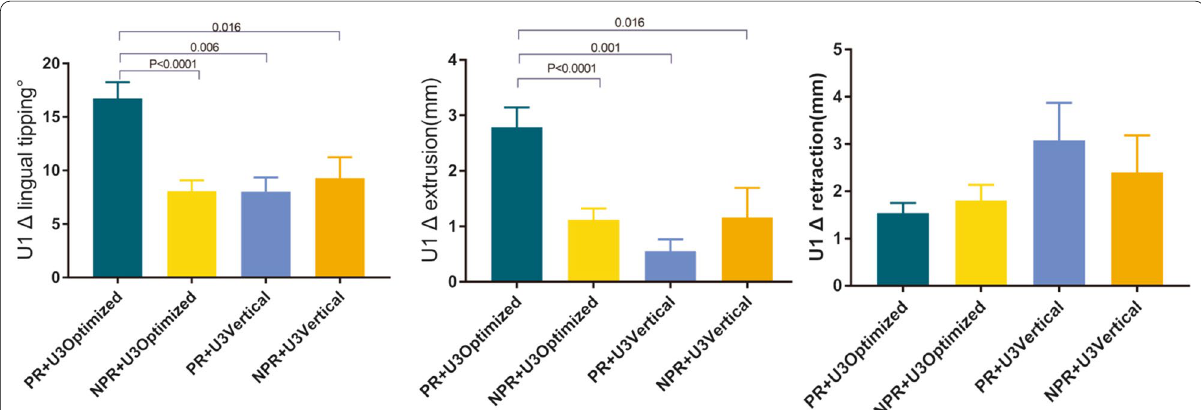
Fig. 3 Variation of upper incisor movements using different canine and incisor attachments. PR, power ridge used on central incisors; NPR, no power ridge on central incisors; U3 Optimized, optimized attachments used on canines; U3 Vertical, vertical attachments used on canines. Δlingual tipping, Δextrusion and Δretraction indicate difference between actual and designed tooth movement. Tukey’s post hoc test was used for pairwise comparison between groups of different attachments with the same